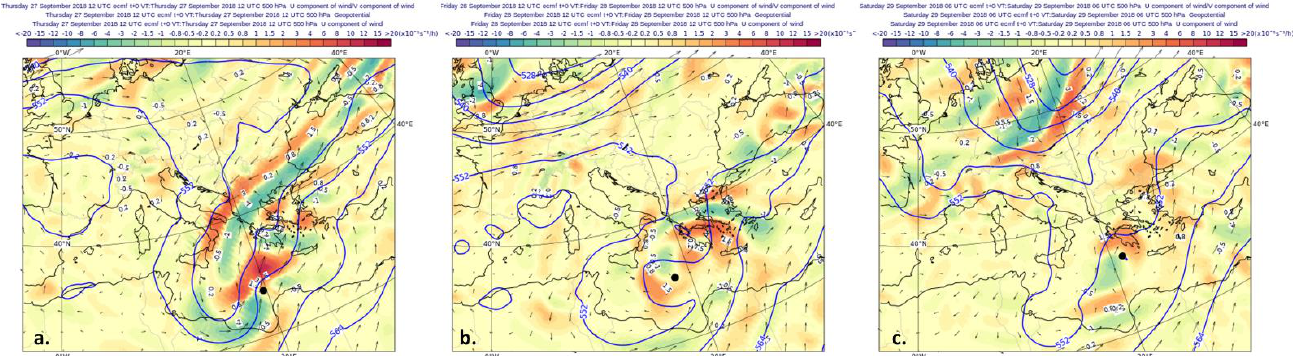
Figure 7. Relative vorticity advection at 500 hPa by the 1000 – 500 hPa thermal wind at ( a ) 27/12 UTC, ( b ) 28/12 UTC, and ( c ) 29/06 UTC. The contours represent the 1000 – 500 hPa thickness, the coloured area the relative vorticity advection and the vectors the 1000 – 500 hPa thermal wind. Black dot on the maps indicates the location of the system centre.